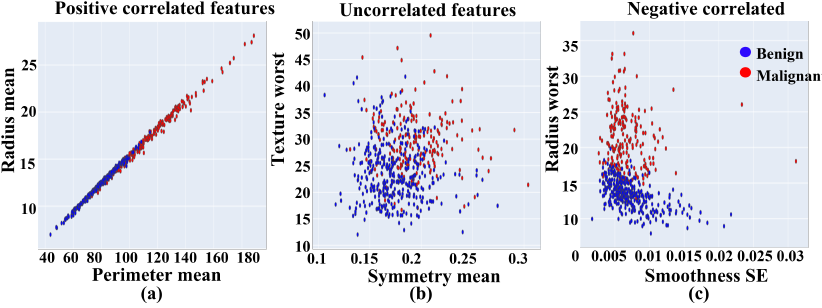
Figure 4. Feature correlation among different samples into positive, negative, and un-correlation of ( a ) Perimeter mean, ( b ) Symmetry mean, and ( c ) Smoothness SE respectively.